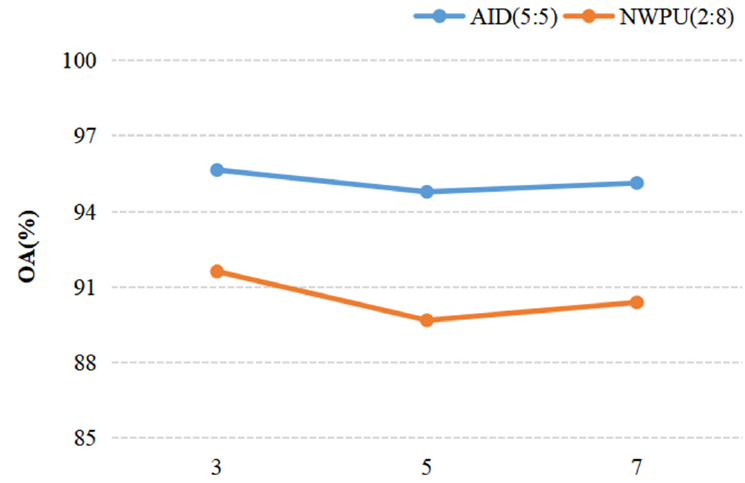
Figure 10. The influence of the ConvLs number.